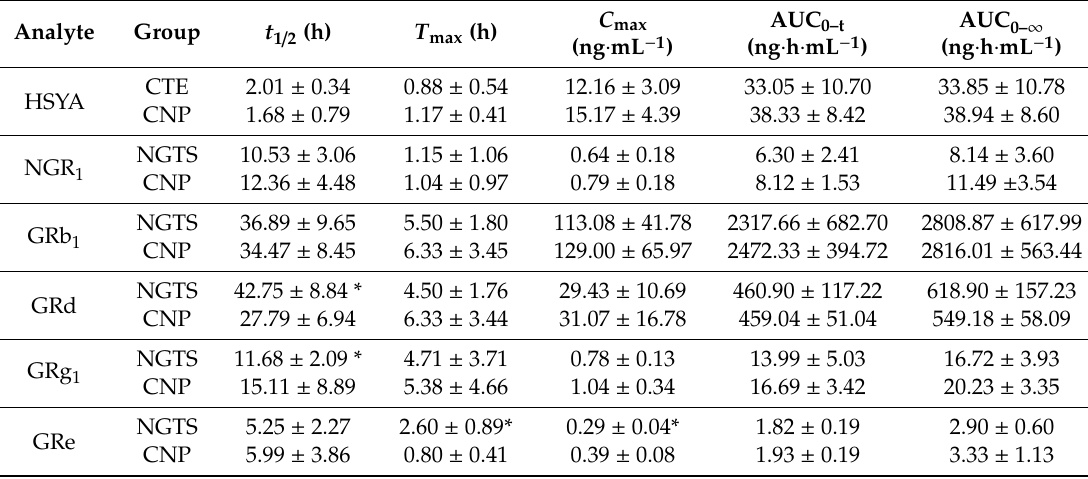
Figure 4. Mean plasma concentration-time profiles of the six analytes in rats after oral administration of CTE, NGTS, and CNP. Each point represents the mean ± SD ( n = 6). Table 1. Pharmacokinetic parameters of hydroxysa ffl or yellow A (HSYA), ginsenoside Re (GRe), (NGR 1 ) after oral administration of CTE, NGTS, and CNP to rats. Each point represents the mean ± SD ( n =